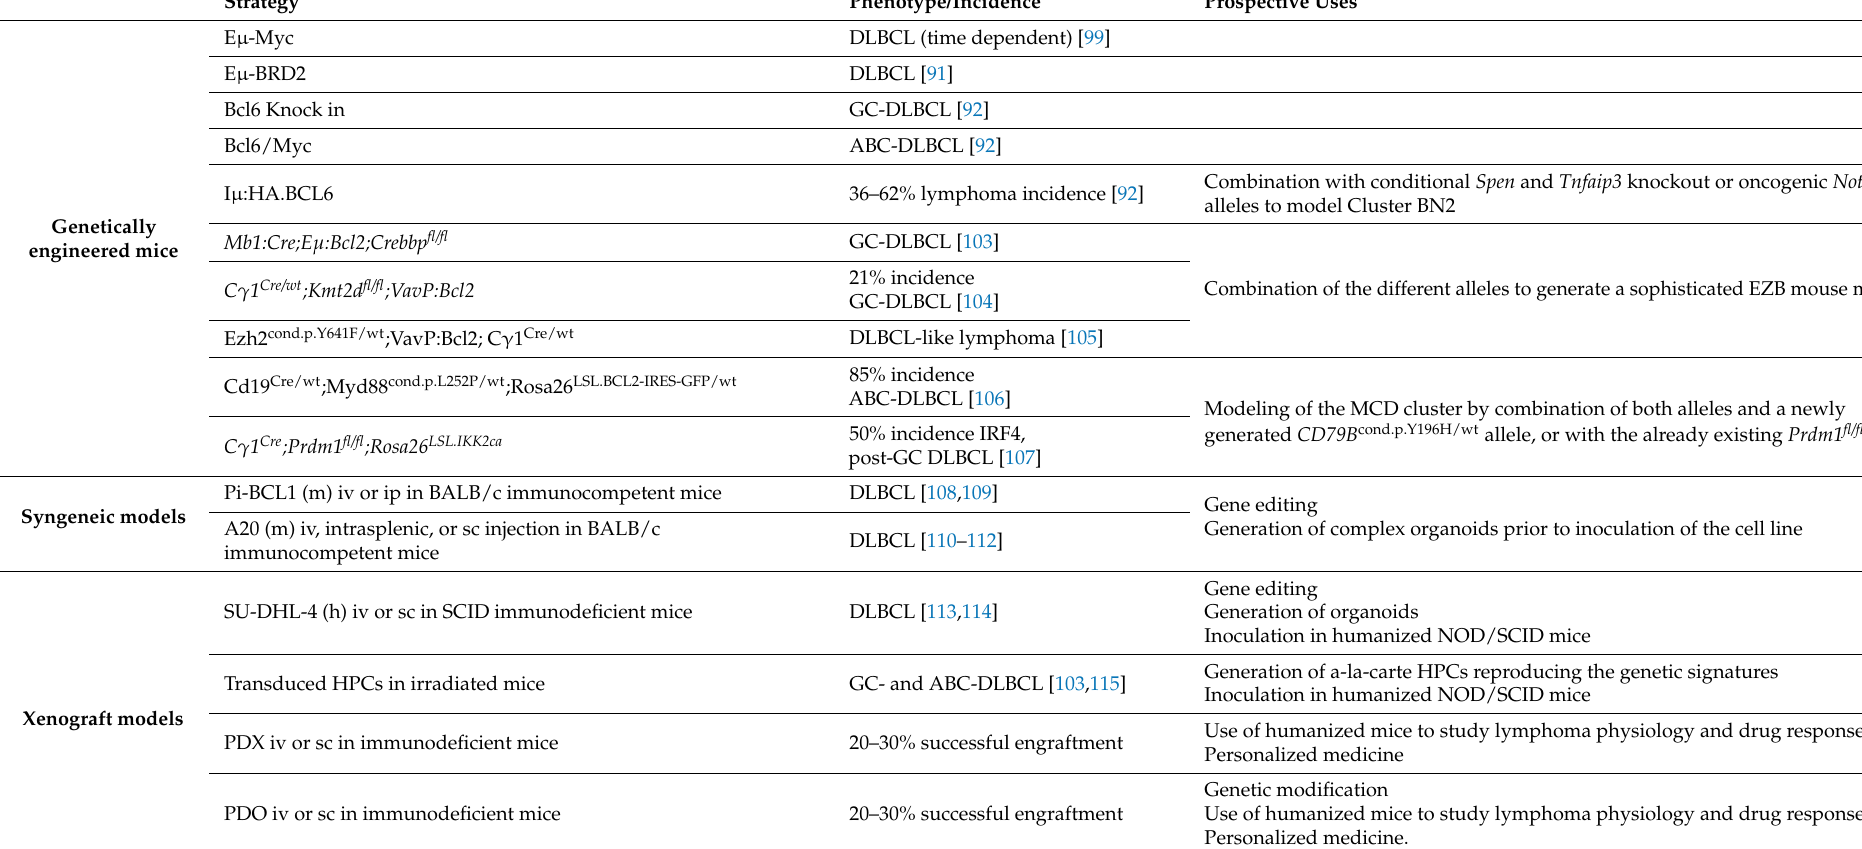
The headings of each mouse model subtype are highlighted in